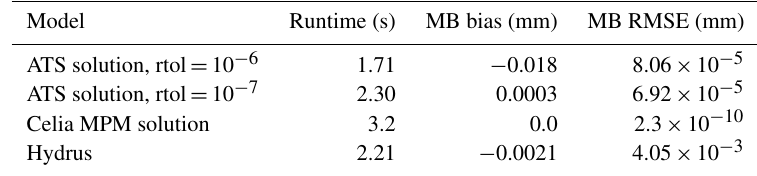
Table 5. Comparison of model runtimes and mass balance